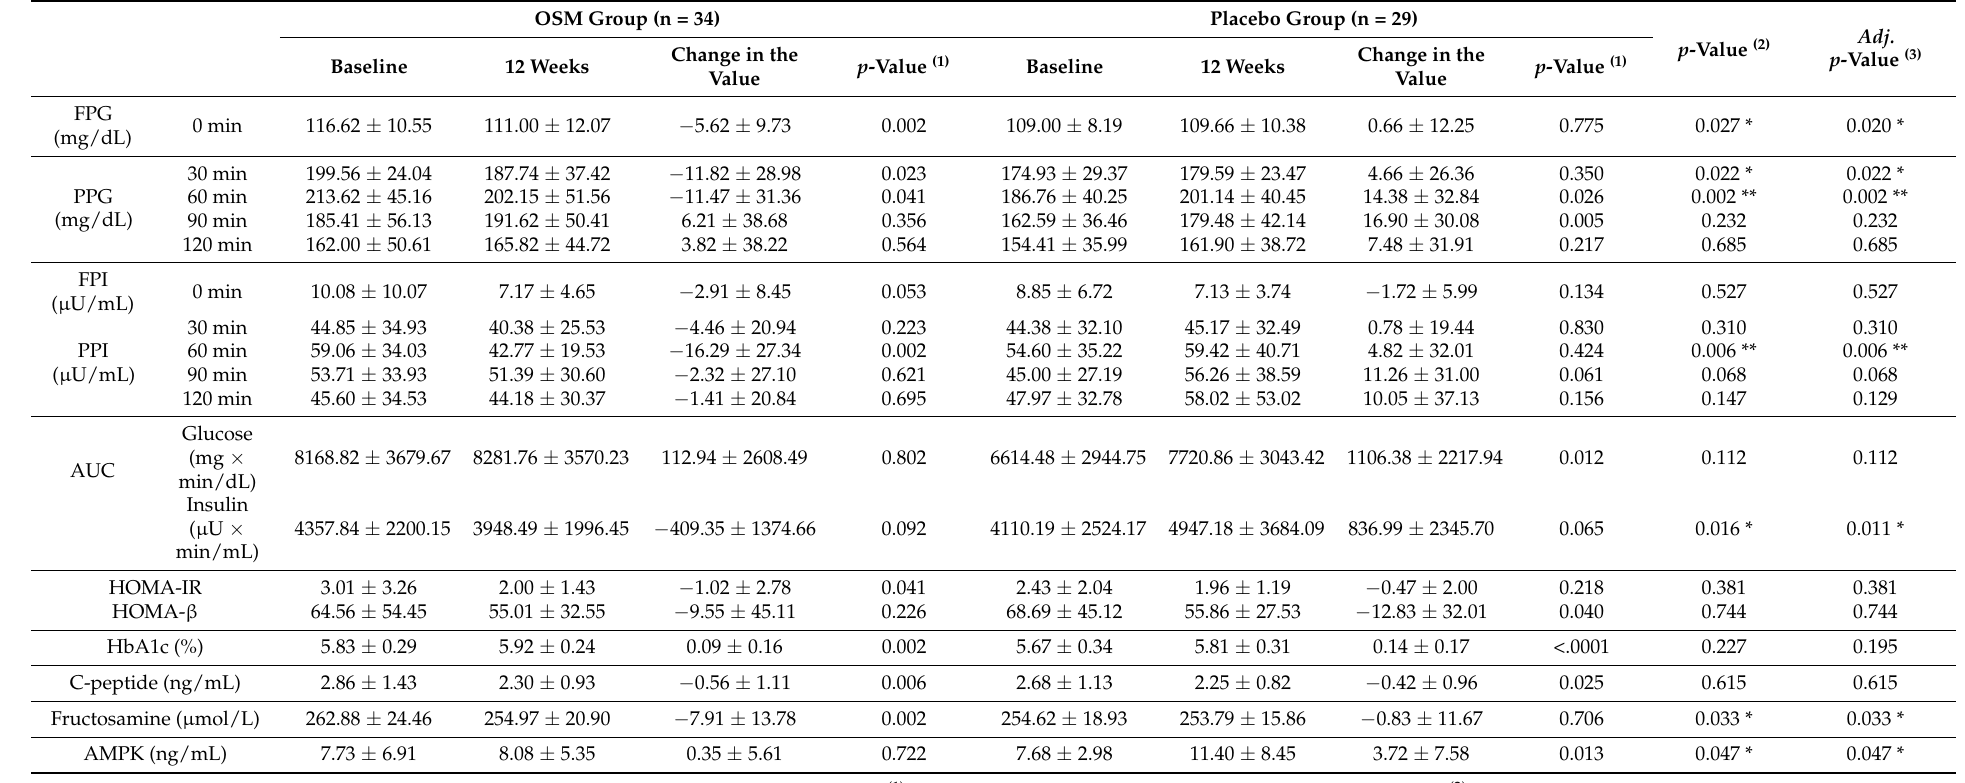
Table 3. Changes in outcomes related to glucose metabolism after intake of OSM or placebo